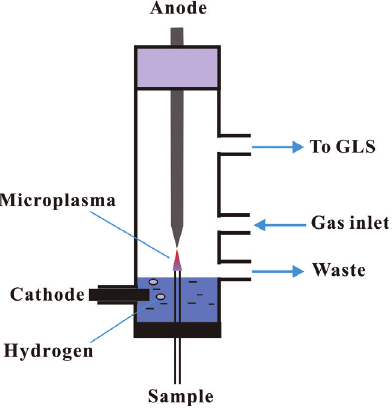
Figure 1 Schematic diagram of SCGD according to the ref. Zhu et al. (2008a). Copyright 2008 American Chemical